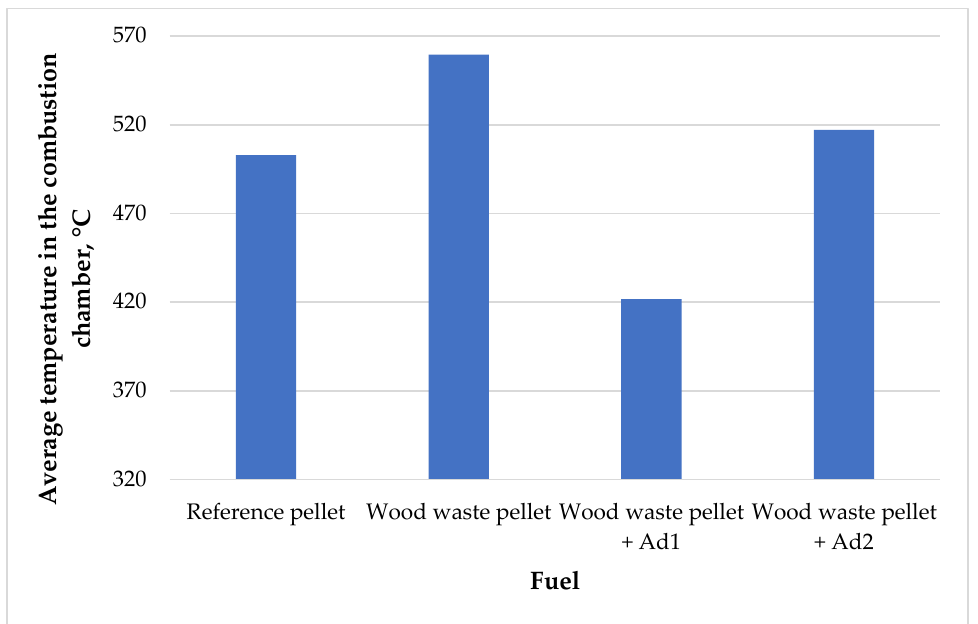
Figure 3. Summary of average temperatures in the boiler’s combustion chamber.